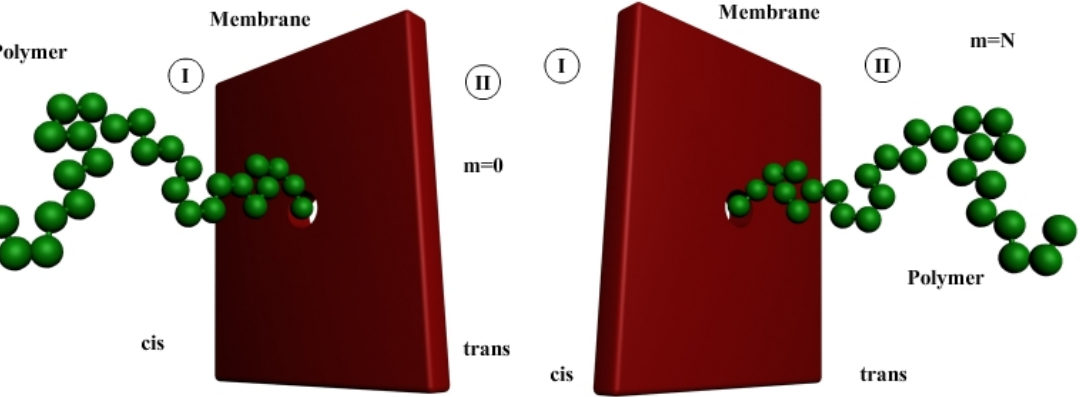
Figure 3. Polymer is found in cis zone ( left side ) and trans zone ( right side ).